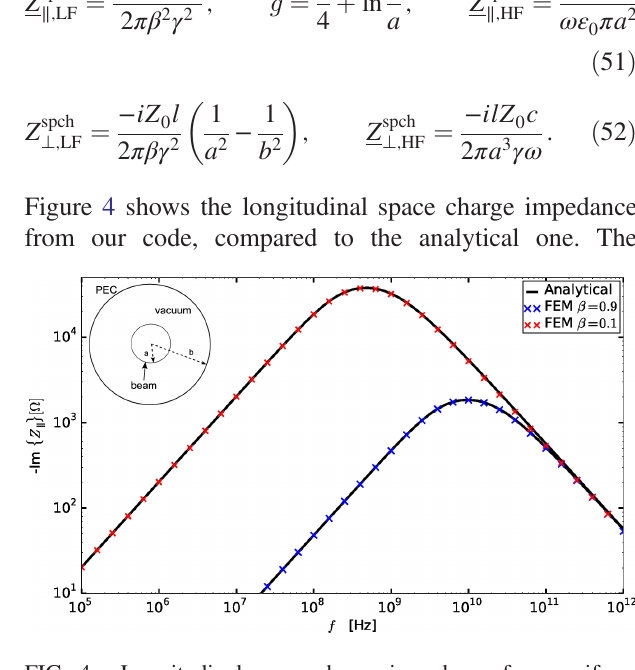
FIG. 4. Longitudinal space charge impedance for a uniform cylindrical beam with radius a ¼ 1 cm, perfectly electric con- ducting (PEC) pipe with radius b ¼ 4 cm, and length l ¼ 1